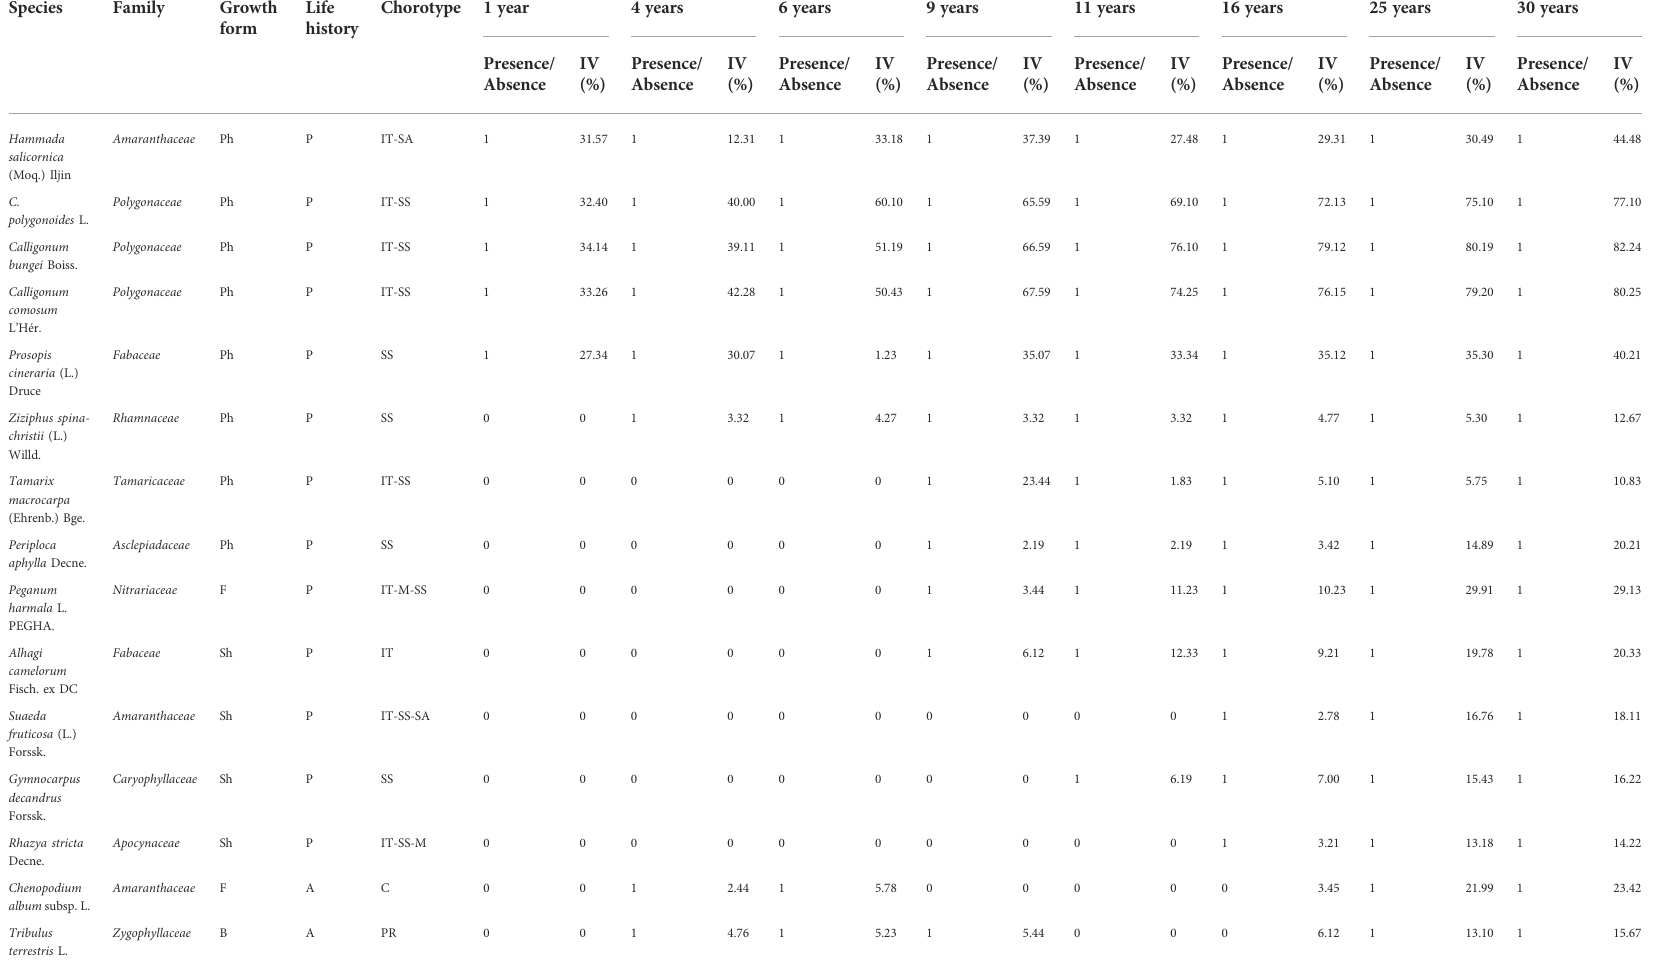
TABLE 1 Plant species composition in the eight study areas (1, 4, 6, 9, 11, 16, 25, and 30 years after afforestation).